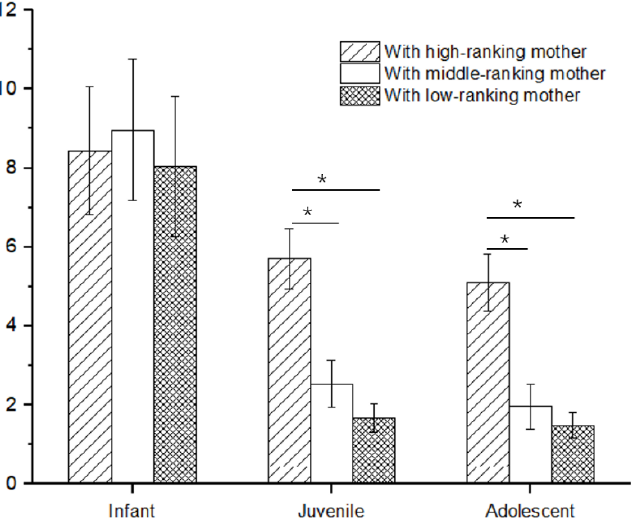
Figure 1. The rate of social play among immature individuals with mothers of different rank categories (* p < 0.05).